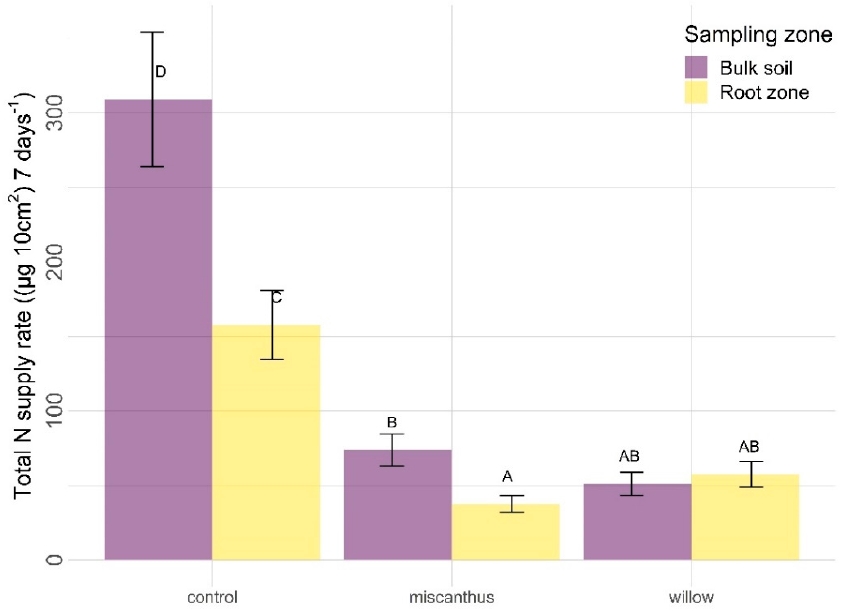
Figure 5. Statistical differences for total N supply rates between sampling zones and treatments. Different letters indicate significance at p < 0.05 using the post hoc Tukey HSD test.